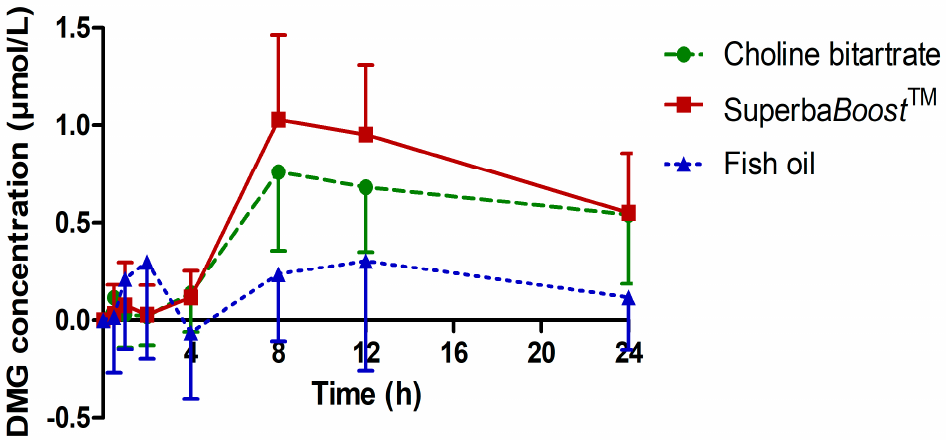
Figure 4. Plasma concentration–time curve of DMG. Values are baseline-corrected. Choline bitartrate: n = 12; Superba Boost TM : n = 12; fish oil: n = 6.